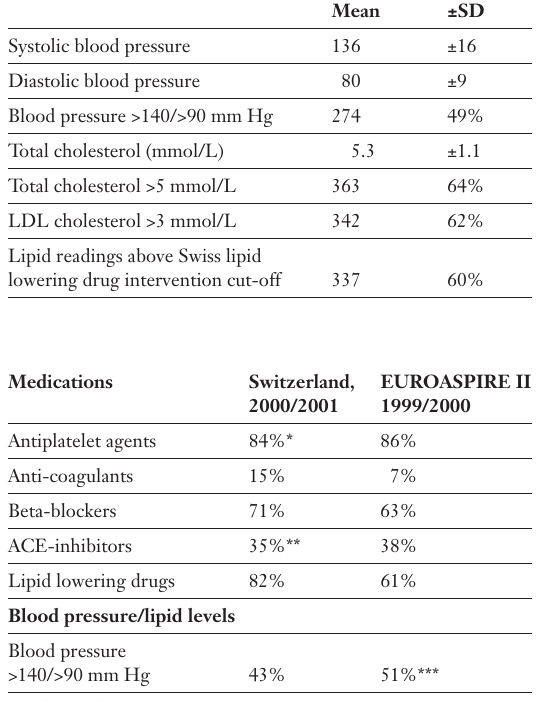
In table 3, blood pressure and lipid readings